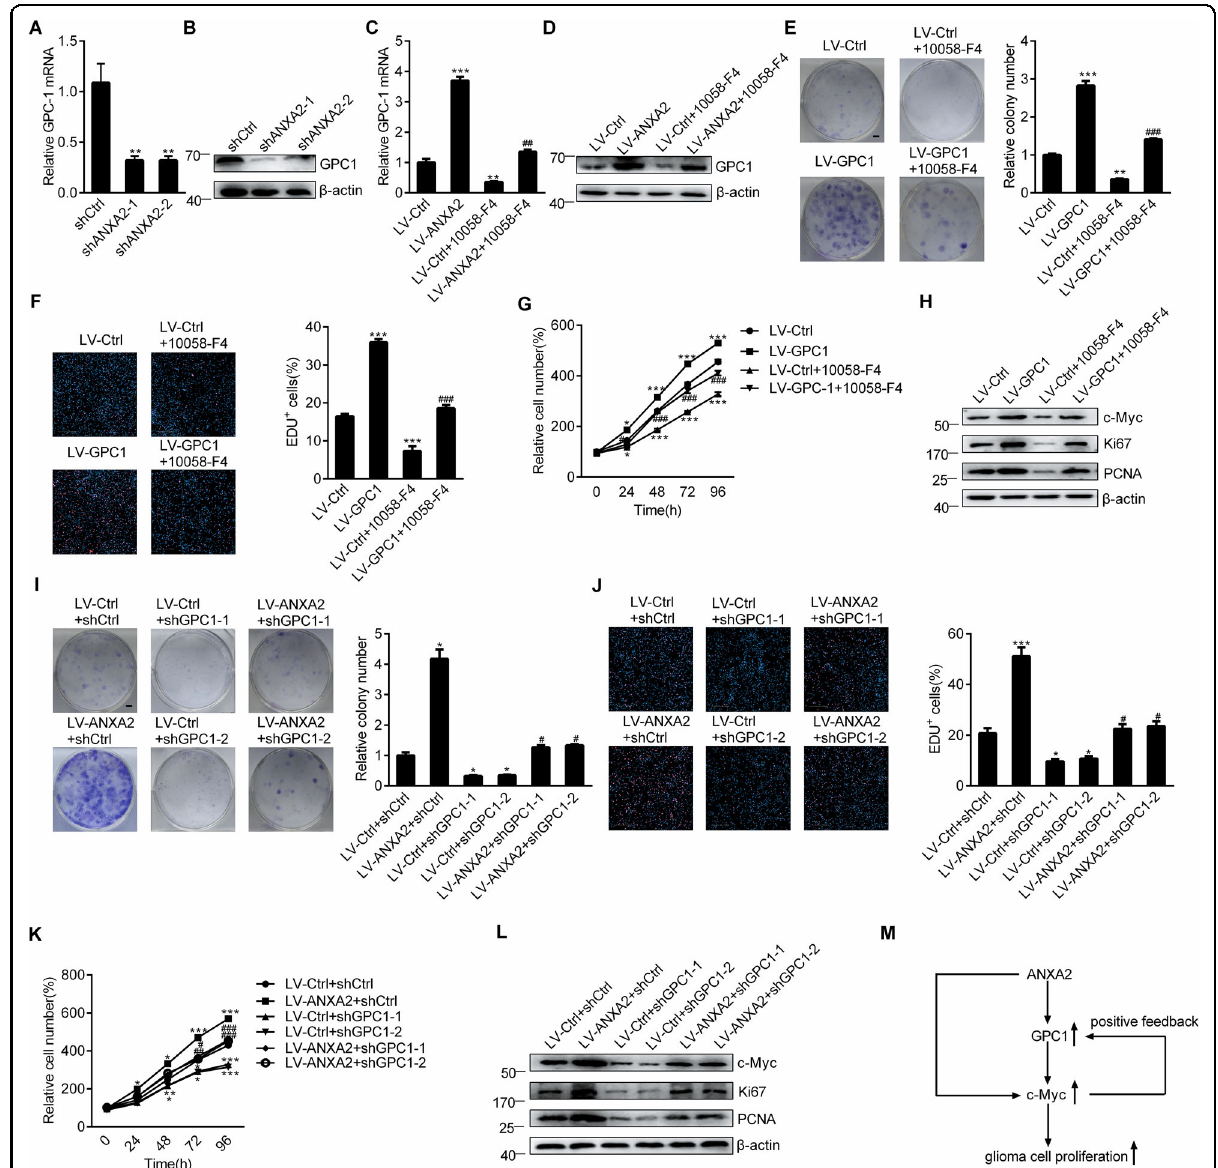
Fig. 2 A GPC1/c-Myc positive feedback loop was formed in ANXA2-induced glioma cell proliferation. A , B The mRNA ( A ) and protein ( B ) levels of GPC1 in stable ANXA2-silenced U118 cells. ∗∗ P < 0.01 vs. shCtrl. C , D Effects of 24 h of 10058-F4 treatment at 10 μ M on the mRNA ( C ) and protein ( D ) levels of GPC1 in U118 cells stably transfected with control or GPC1 lentiviruses. E – G Effects of 24 h of 10058-F4 treatment at 10 μ M on the proliferation of U118 cells stably transfected with control or GPC1 lentiviruses shown by colony formation ( E ) (Scale bar = 5 mm), EdU immuno fl uorescence staining ( F ) (Scale bar = 200 μ m) and CCK-8 ( G ) assays. ∗ P < 0.05; ∗∗ P < 0.01; ∗∗∗ P < 0.001 vs. LV-Ctrl, # P < 0.05; ## P < 0.01; ### P < 0.001 vs. LV-GPC1. H Effects of 24 h of 10058-F4 treatment at 10 μ M on the protein levels of c-Myc and proliferation markers (Ki67 and PCNA) in U118 cells stably transfected with control or GPC1 lentiviruses. I – K U118 cells stably overexpressing ANXA2 were infected with shCtrl or shGPC1 lentiviruses for 72 h or 24 – 96 h, and cell proliferation was assessed and shown by colony formation ( I ) (Scale bar = 5 mm), EdU immuno fl uorescence staining ( J ) (Scale bar = 200 μ m), and CCK-8 ( K ) assays. ∗ P < 0.05; ∗∗ P < 0.01; ∗∗∗ P < 0.001 vs. LV-Ctrl + shCtrl, # P < 0.05; ## P < 0.01; ### P < 0.001 vs. LV-ANXA2 + shCtrl. L U118 cells stably overexpressing ANXA2 were infected with shCtrl or shGPC1 lentiviruses for 72 h, and western blot analysis of c-Myc and proliferation markers (Ki67 and PCNA) was performed. M Schematic summarizing the results demonstrating the GPC1/c-Myc positive feedback loop in ANXA2-induced glioma cell proliferation. Error bars represent the standard error of the mean.